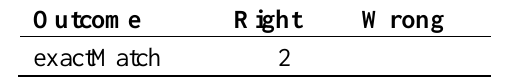
Table 14. Summary results of the matching process between W and U